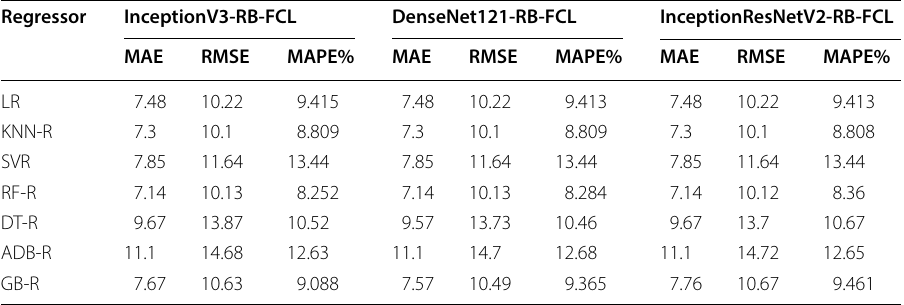
Table 5 Result of Region Based Feature Connected Layer (RB-FCL) output for RSNA dataset